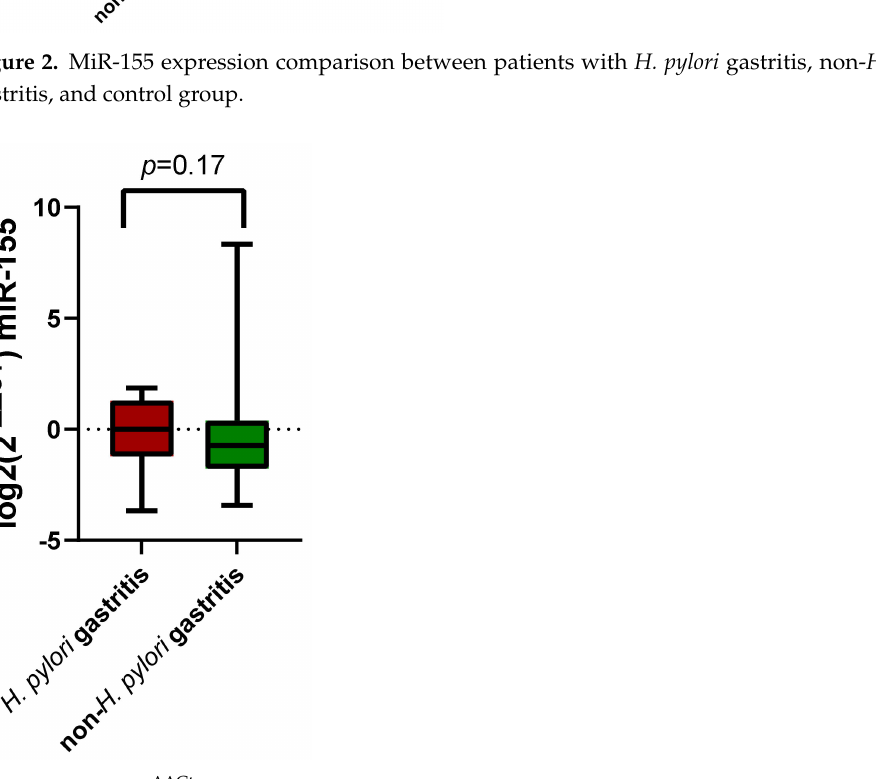
Figure 3. Log 2 (2 − ∆∆ Ct ) miR-155 comparison between patients with H. pylori gastritis and non- H. pylori